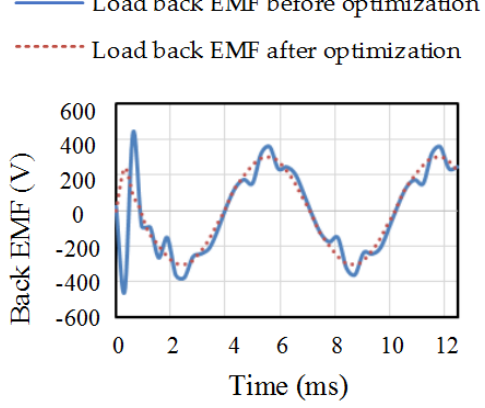
Figure 9. Back EMF of the AFPMSM at the rated load.